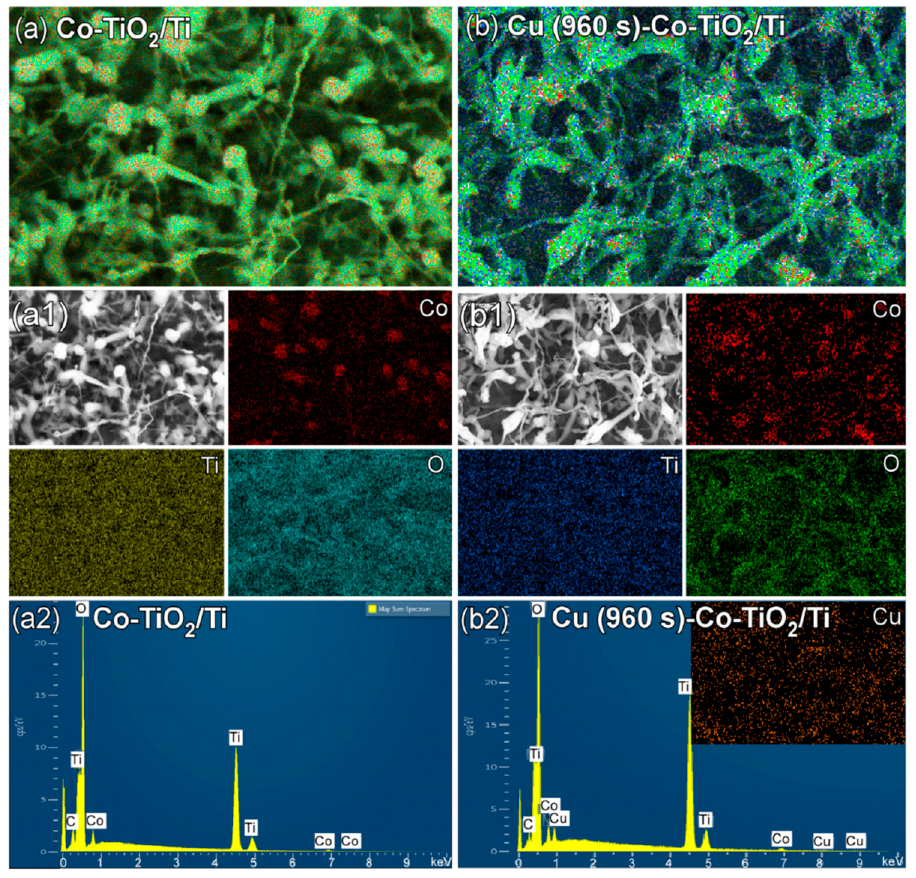
Figure 4. Layered ( a , b ) and elemental (Co, Ti, O and Cu ( a1 , b1 )) mapping images and EDXS profiles ( a2 , b2 ) of Co-TiO 2 /Ti ( a , a1 , a2 ) and Cu (960 s)-Co-TiO 2 /Ti ( b , b1 , b2 ).